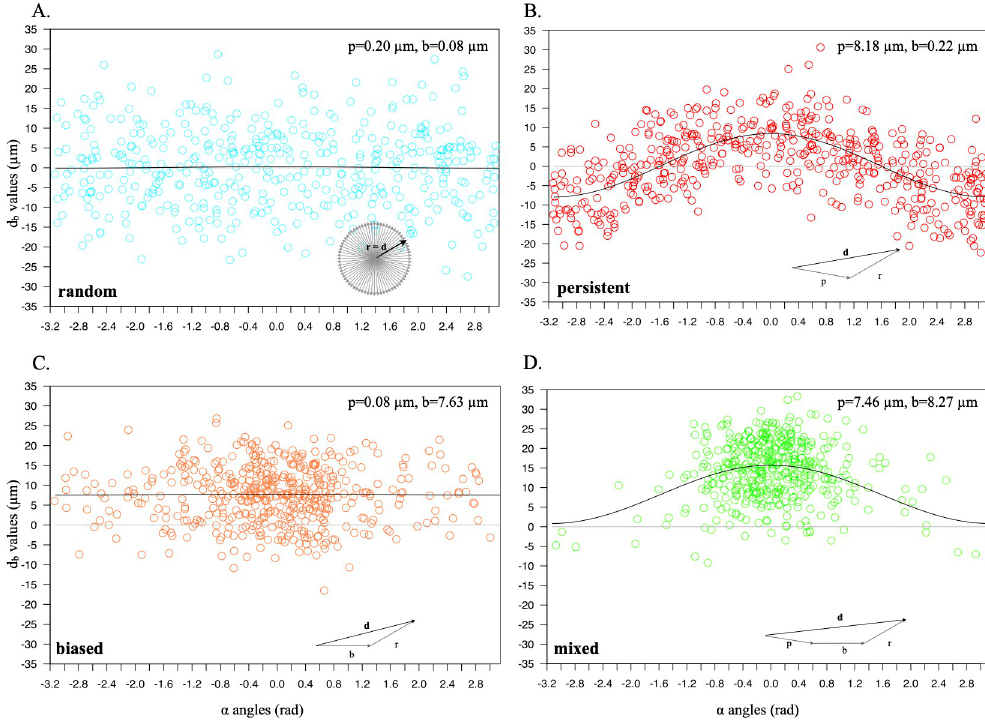
Fig 2. Persistence and bias effect on directional component of cell movement. The directional components of cell displacements from cell populations are plotted (y axis) against their α angles (x axis); (A, B) correspond to populations generated by simulating random ( p = 0 μ m; b = 0 μ m), persistent ( p = 8 μ m; b = 0 μ m), biased ( p = 0 μ m; b = 8 μ m) and mixed movements ( p = 8 μ m; b = 8 μ m). The continuous line corresponds to curves identified by fitting the described model to the data; the numerical parameters are shown on the top of each